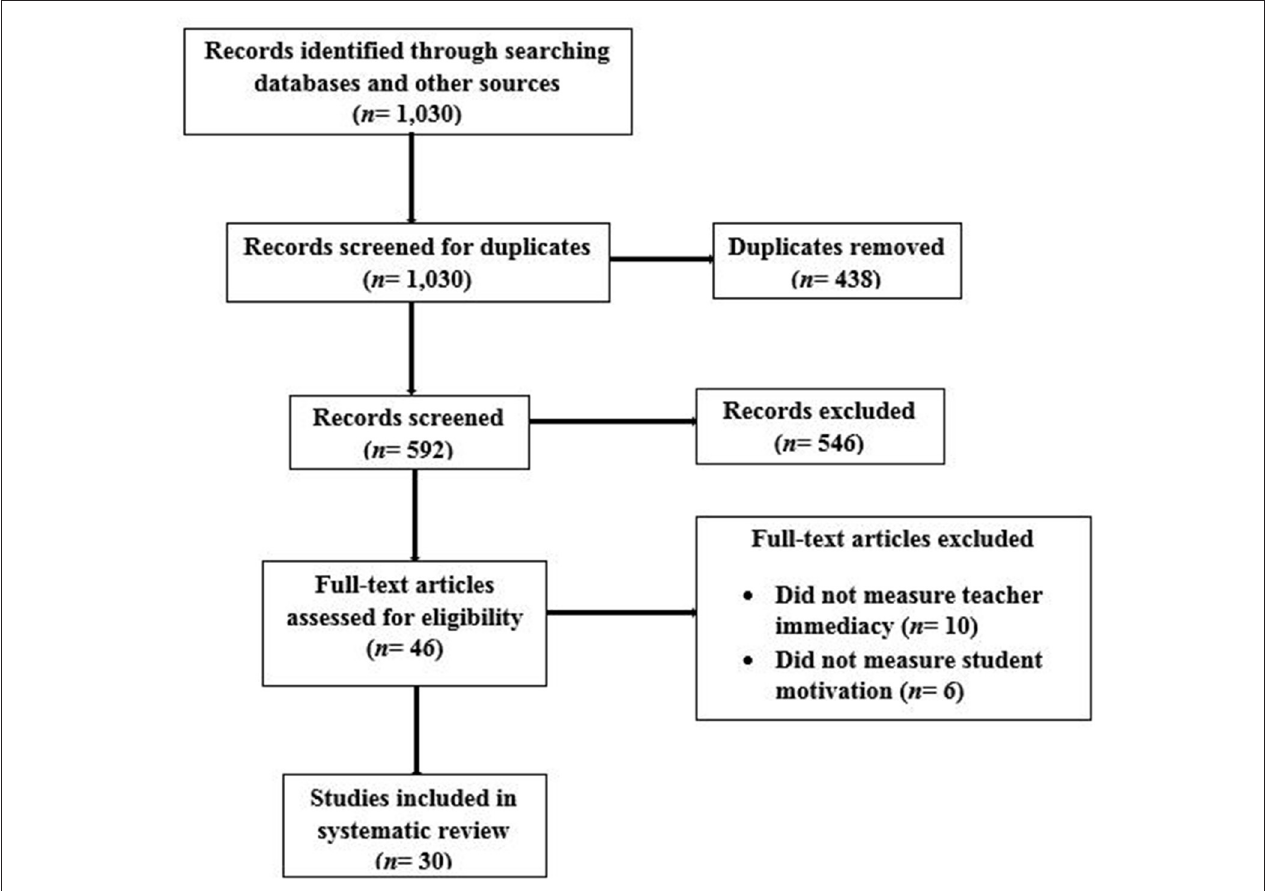
FIGURE 1 | PRISMA diagram demonstrating study